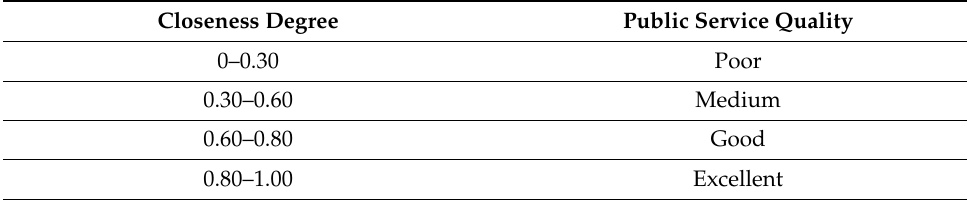
Table 2. The standards for judging the quality of public service.